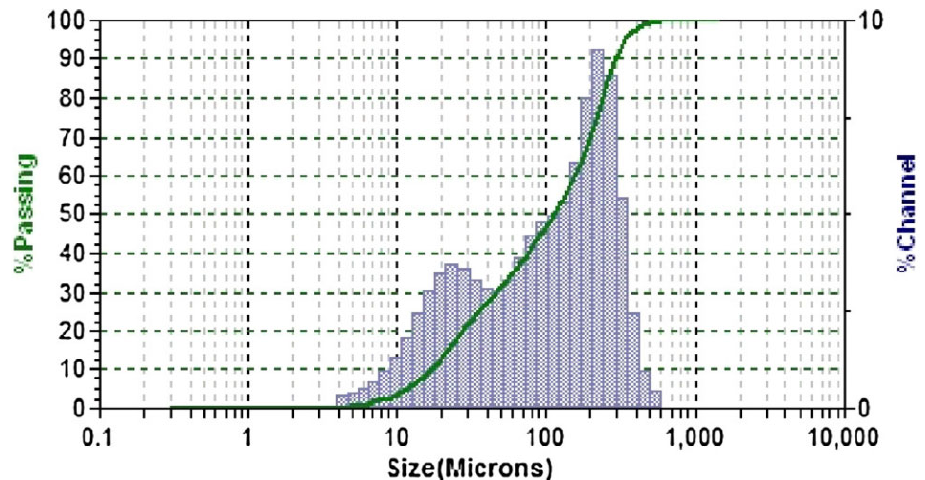
Figure 14. Size distribution of the dust sample. Reprinted from Solar Energy, 141, Mehmood U. et al., Characterization of dust collected from PV modules in the area of Dhahran, Kingdom of Saudi Arabia, and its impact on protective transparent covers for photovoltaic applications, 205., Copyright (2017), with permission from Elsevier [66].